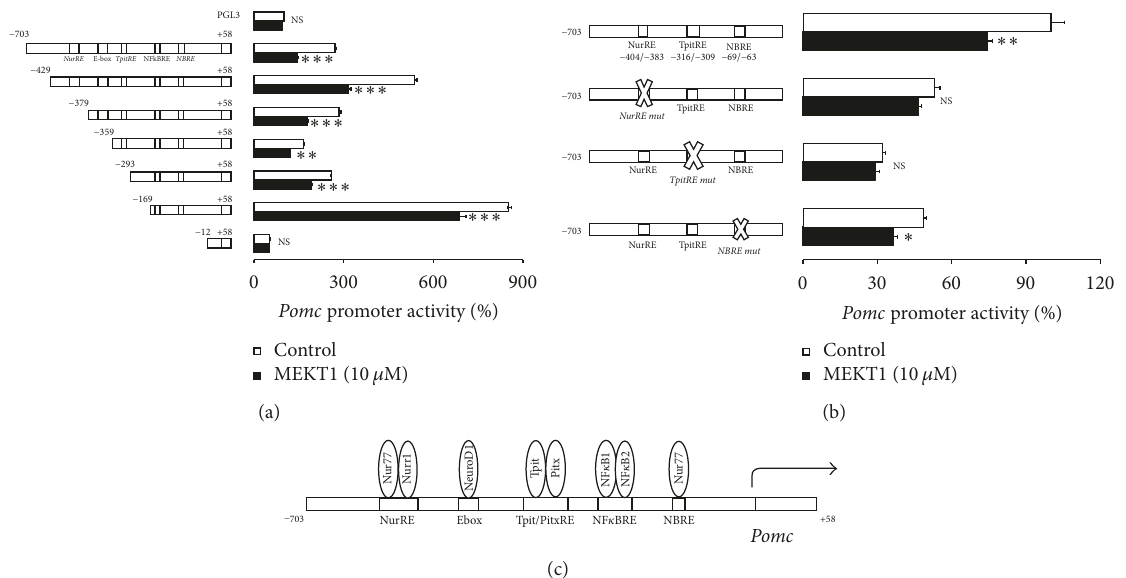
Figure 6: Effects of MEKT1 on Pomc promoter deletion mutants and role of NurRE, TpitRE, and NBRE on MEKT1-mediated effect on Pomc promoter activity in AtT20 cells. (a) MEKT1-mediated effect on Pomc promoter deletion mutants. AtT20 cells transiently transfected with 300 ng rPomc-Luc ( − 703/+58-luc) or each deletion mutant reporter plasmid ( − 429/+58-Luc, − 379/+58-Luc, − 359/+58-Luc, − 293/+58, − 169/+58,and+12/+58)and100 ngpRSV- 𝛽 -galwereincubatedinthepresence(10 𝜇 M)orabsenceofMEKT1for24hoursbeforetheluciferase assay. Data are expressed as percentages of each control (100% in pGL3-Basic). (b) MEKT1-mediated effect on Pomc promoter activity using NurRE mut, TpitRE mut, and NBRE mut. AtT20 cells transiently transfected with 300ng r Pomc -Luc ( − 703/+58-luc) or NurRE mut (r Pomc - Luc- NurRE -Mut), TpitRE mutant (r Pomc -Luc- TpitRE -Mut), NBRE mutant of Pomc promoter (r Pomc -Luc- NBRE -Mut) of Pomc full length promoter and 150 ng pRSV- 𝛽 -gal were incubated in the presence (10 𝜇 M) or absence of MEKT1 for 24 hours before the luciferase assay. Data are expressed as percentages of each control (100% in r Pomc -Luc). Data represent mean ± SEM ( 𝑛 = 4 ). NS denotes “not significant.” ∗ 𝑃 < 0.05 , ∗∗ 𝑃 < 0.01 , and ∗∗∗ 𝑃 < 0.001 versus control. (c) Graphical representation of responsive elements on the promoter of Pomc and transcription factors which bind to the responsive elements of Pomc